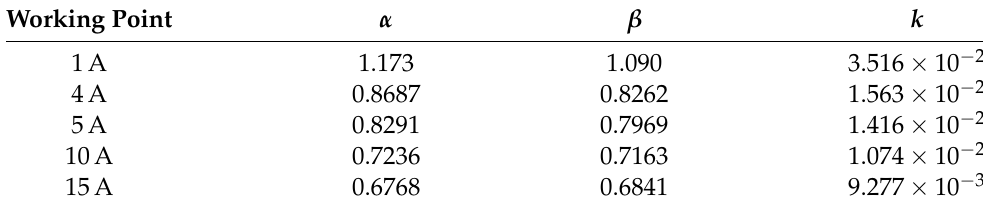
Figure 19. Free parameter plot with p = 65rad/s 1 − α and z = 100rad/s 1 − β , the corresponding interpolation laws (green), and the fitted working point at 7A (red). Table 2. Parameter values for the second identification